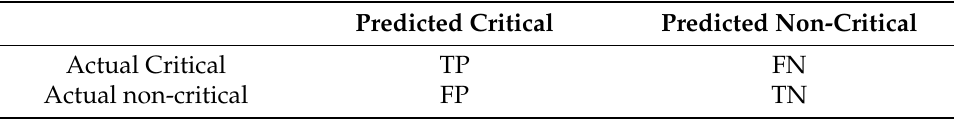
Table 3. Confusion matrix for COVID-19 severity